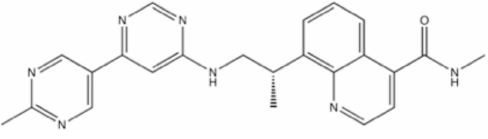
Figure 12. Structure of VX-984.